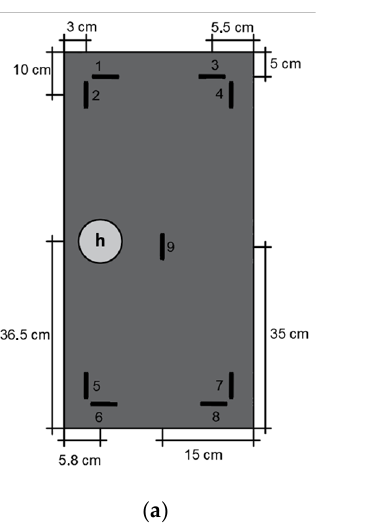
Figure 1. ( a ) FBG sensors’ position and identification and location of the corrosion site on the metal plate; ( b ) photograph of the experimental apparatus.